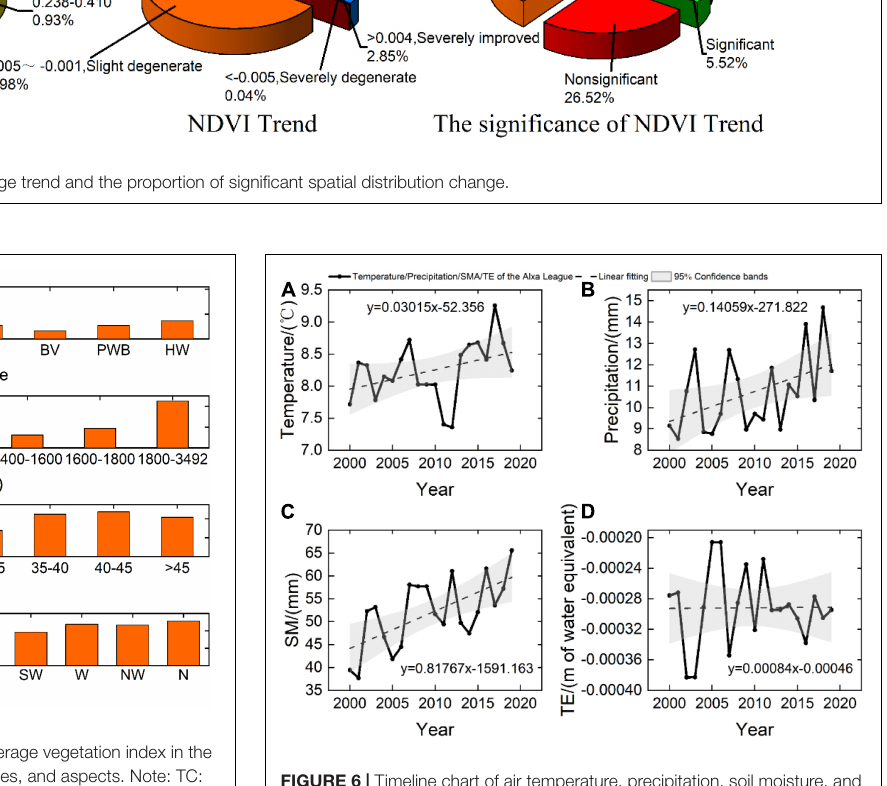
FIGURE 6 | Timeline chart of air temperature, precipitation, soil moisture, and total